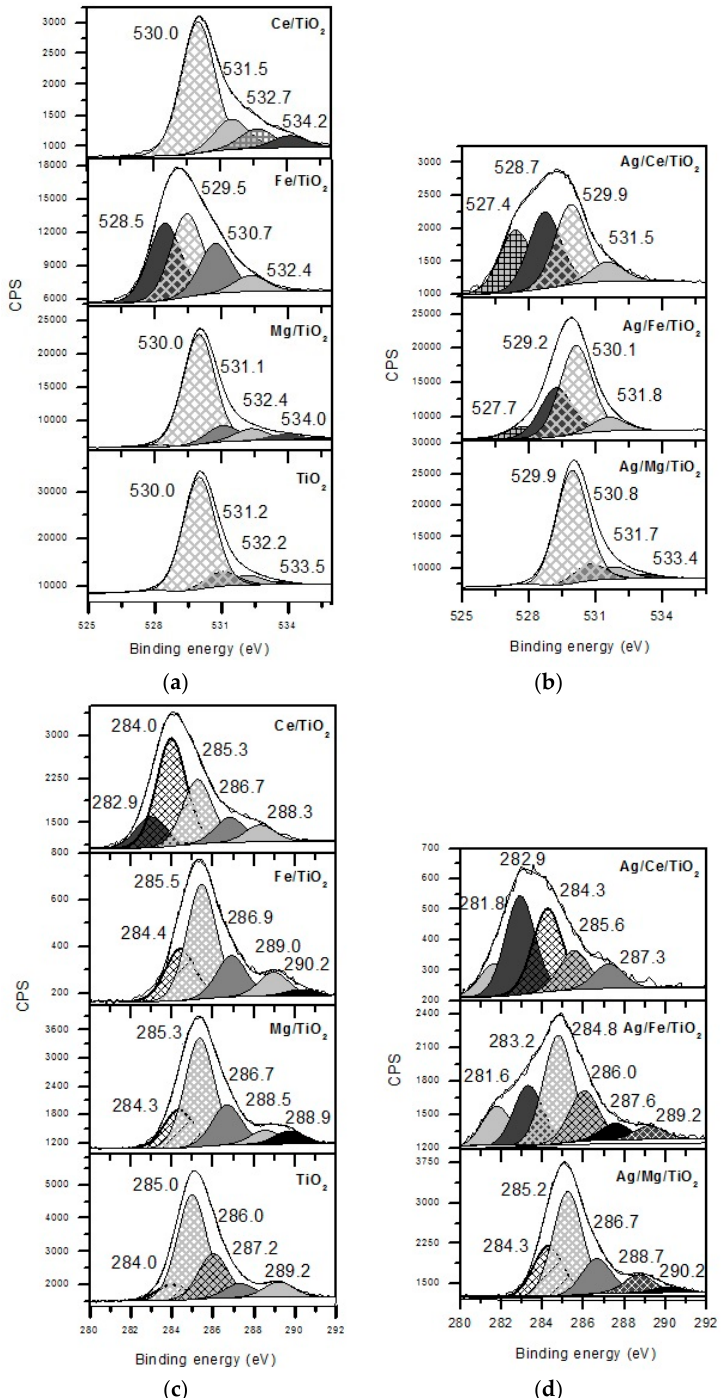
Figure 8. XPS lines of O1s ( a , b ) and C1s ( c , d ) for supports ( a , c ) and Ag catalysts after reduction in H 2 at 300 °C for 1 h ( b , d ).